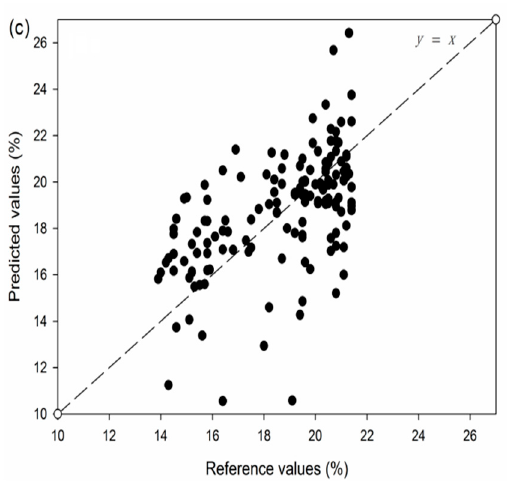
Figure 5. The plots of the predicted values verses the reference values of prediction sets based on least-squares support vector machine regression (( a ) master instrument; ( b ) linear interpolation-PDS; ( c ) common-wavelengths-reserved-PDS).